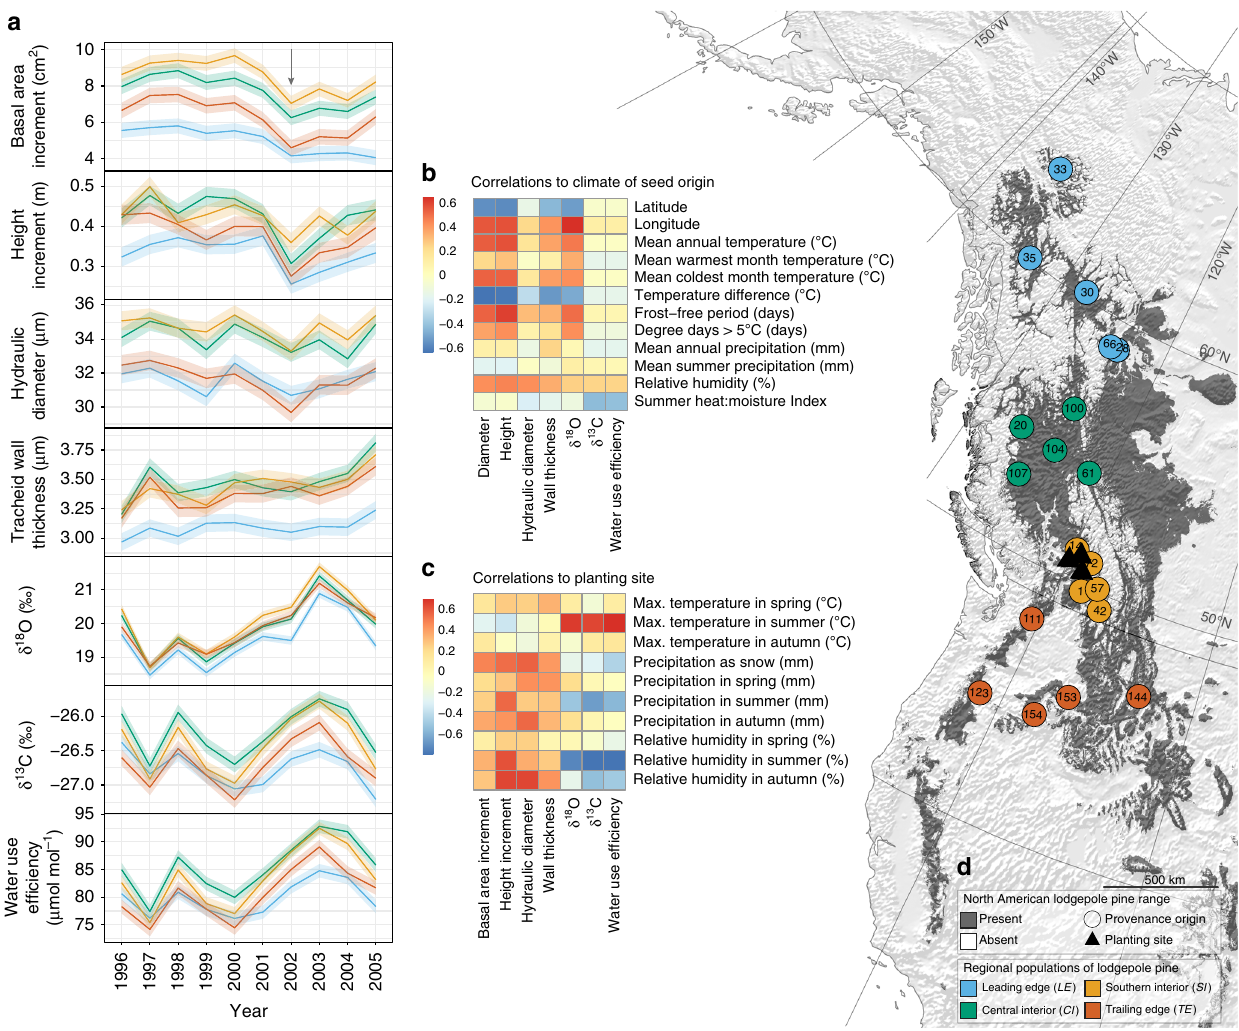
Fig. 1 Variations in growth and physiology of lodgepole pine ( Pinus contorta ) in relation to climate and provenance. a Growth, functional wood anatomical traits, stable isotope values and δ 13 C-derived intrinsic water-use ef fi ciency. Lines and standard errors (ribbons) are colored according to the regional population within the species distribution: blue represents the leading edge (northern) population; green represents the central interior population; yellow represents the southern interior population and orange represents the trailing-edge (far southern) population ( n = 1170: 4 populations × 5 provenances × 1 tree × 3 sites × 2 blocks × 10 years, minus 3 trees). Grey arrow indicates drought year. b Correlations of growth and physiological traits to climate of seed origin. These were based on total height and diameter at age 32 and were correlated to long-term climates from 1961 – 1990 ( n = 117). c Correlations of growth and physiological traits to annual climate variables at the planting sites. These were based on annual height and basal area increments related to weather on the planting sites over the 10 years ( n = 600). d Lodgepole pine distribution (dark grey) in western North America and the experimental design. The map was produced by the authors with ArcInfo 10.1 using vector and raster data from www.naturalearthdata.com (Public